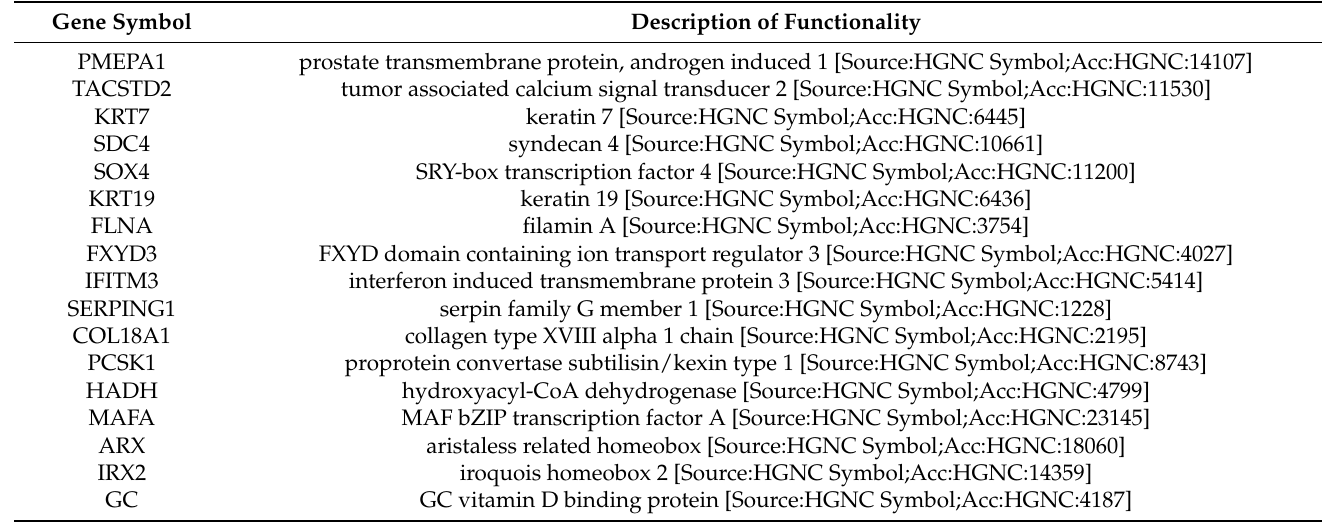
Table A3. List of 17 out of 20 overlapped genes between our top 20 ranked genes and pancreas gene sets (Data2).